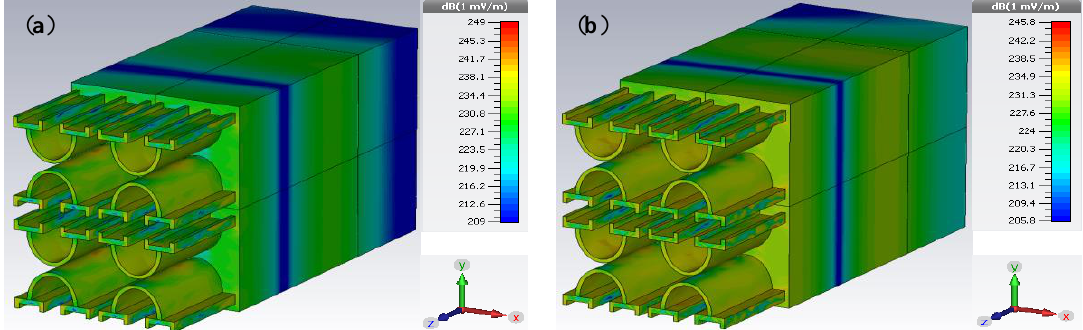
Figure 9. Electric field distributions under the TE-polarized incidence excitation corresponding to ( a ) λ = 565.11 nm, θ = 30° and ( b ) λ = 541.2 nm, θ = 70° , taking into account 𝑑 = 50 nm and 𝑡 = 100 nm.